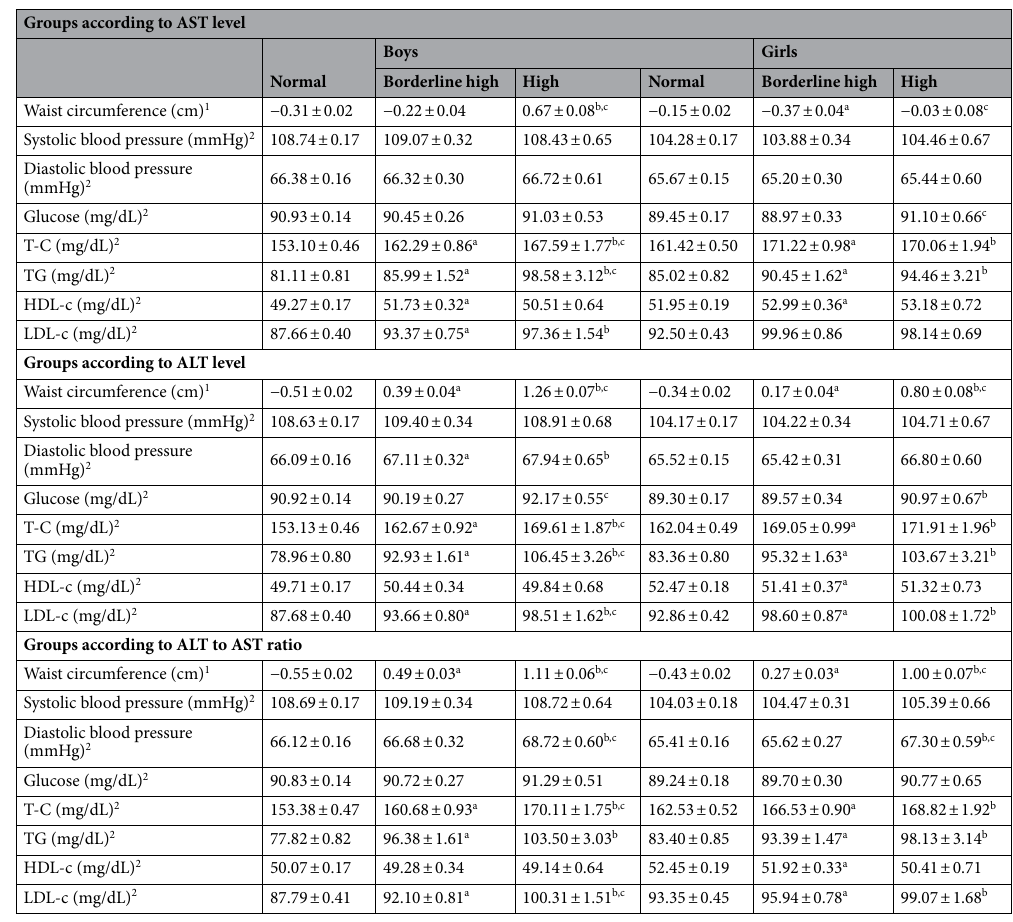
Table 3. The adjusted means and standard errors (SE) of cardiometabolic risk factors for groups according to aspartate transaminase (AST), alanine transaminase (ALT), and the AST/ALT ratio in children aged 10–18 years ( n = 8091). The results are expressed as the mean ± standard error (SE). WC, waist circumference; SDS, standard deviation score; BMI, body mass index; SBP, systolic blood pressure; DBP, diastolic blood pressure; T-C, total cholesterol; TG, triglyceride; HDL-c, high-density lipoprotein cholesterol; LDL-c, low- density lipoprotein cholesterol. The normal group was classified as i) aspartate aminotransferase (AST) levels < 23 IU/L in boys, and < 20 IU/L in girls, ii) alanine aminotransferase (ALT) level < 19 IU/L in boys, and < 14 IU/L in girls, and iii) AST/ALT ratio > 1.10 in boys, and > 1.35 in girls. The borderline-high group was classified as i) AST level ≥ 23 IU/L and 32 < IU/L in boys, and ≥ 20 IU/L and 26 < IU/L in girls, ii) ALT level ≥ 19 IU/L and < 40 IU/L in boys, and ≥ 14 IU/L and < 23 IU/L in girls, and iii) AST/ALT ratio < 0.65 and ≤ 1.10 in boys, and < 0.90 and ≤ 1.35 in girls. The high group was classified as i) AST level ≥ 32 IU/L in boys, and ≥ 26 IU/L in girls, ii) ALT level ≥ 40 IU/L in boys, and ≥ 23 IU/L in girls, and iii) AST /ALT ratio ≤ 0.65 in boys, and ≤ 0.90 in girls. Model 1: The adjusted means of waist circumference (WC) were estimated using analysis of covariance (ANCOVA) with Bonferroni’s post-hoc test after adjustment for age, alcohol consumption, smoking, physical activity, residence, household income, and diagnosis of hypertension, diabetes mellitus and dyslipidemia in the respective sex according to groups for AST, ALT and the AST/ALT ratio. Model 2: The adjusted means of systolic blood pressure (SBP), diastolic blood pressure (DBP), glucose, total cholesterol (T-C), triglyceride (TG), high-density lipoprotein cholesterol (HDL-c), and low-density lipoprotein cholesterol (LDL-c) were estimated using analysis of covariance (ANCOVA) with Bonferroni’s post-hoc test after adjustment for age, body mass index (BMI) standard deviation score (SDS), alcohol consumption, smoking, physical activity, residence, household income, and diagnosis of hypertension, diabetes mellitus and dyslipidemia in the respective sexes according to groups for AST, ALT and the AST/ALT ratio. a The difference was estimated between the normal group and the borderline-high group using analysis of covariance with Bonferroni’s post-hoc test. b The difference was estimated between the normal group and the high group using analysis of covariance with Bonferroni’s post-hoc test. c The difference was estimated between the borderline- high group and the high group using analysis of covariance with Bonferroni’s post-hoc